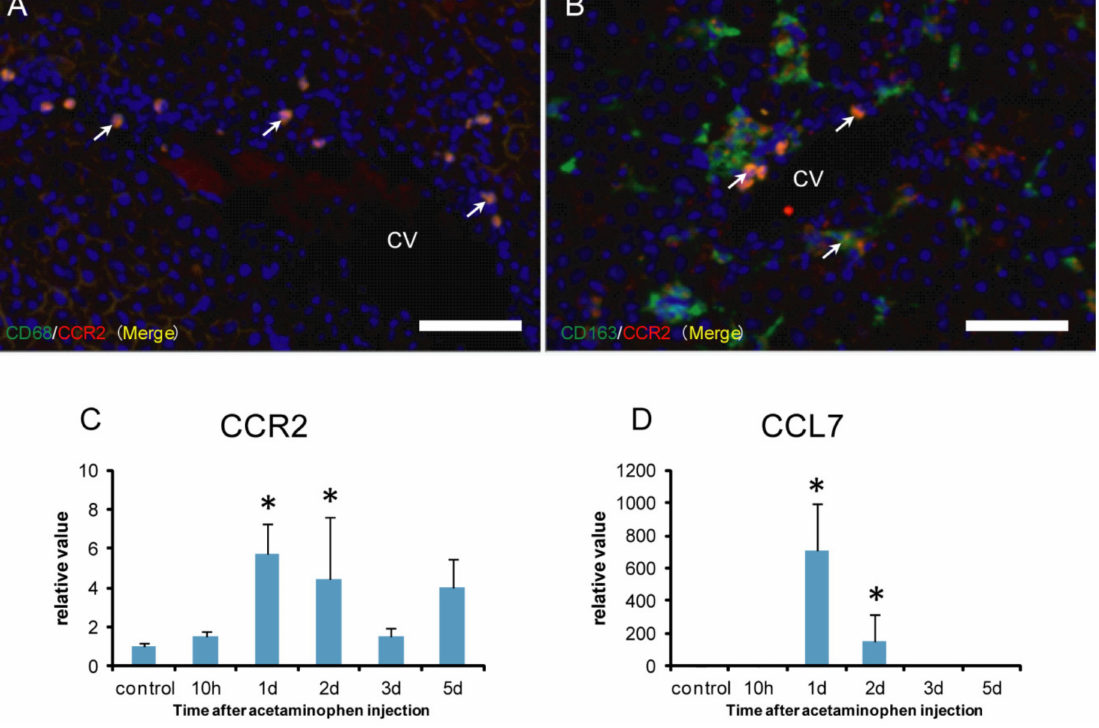
Figure 8. Double immunofluorescence with combinations of CD68 / CCR2 ( A ) and CD163 / CCR2 ( B ) on day 2, and mRNA expressions for CCR2 ( C ) and CCL7 ( D ) in APAP-induced rat hepatotoxicity. Almost all CD68 positive macrophages label CCR2 (A) (close to 100%), whereas double-positive cells with CCR2 / CD163 were very few ( B ) (less than 10%). Yellow color (arrows) indicates double-positive reactions. Blue is nucleus stained with 4’,6-diamino-2-phenylindole (DAPI). mRNA expression levels of CCR2 ( C ) and CCL7 ( D ), normalized by the expression levels of 18s RNA, are significantly increased on days 1 and 2. Dunnett’s test; *, significantly di ff erent from controls at p < 0.05. Bar represents the mean ± SD. CV, central vein. Bar = 40 µ